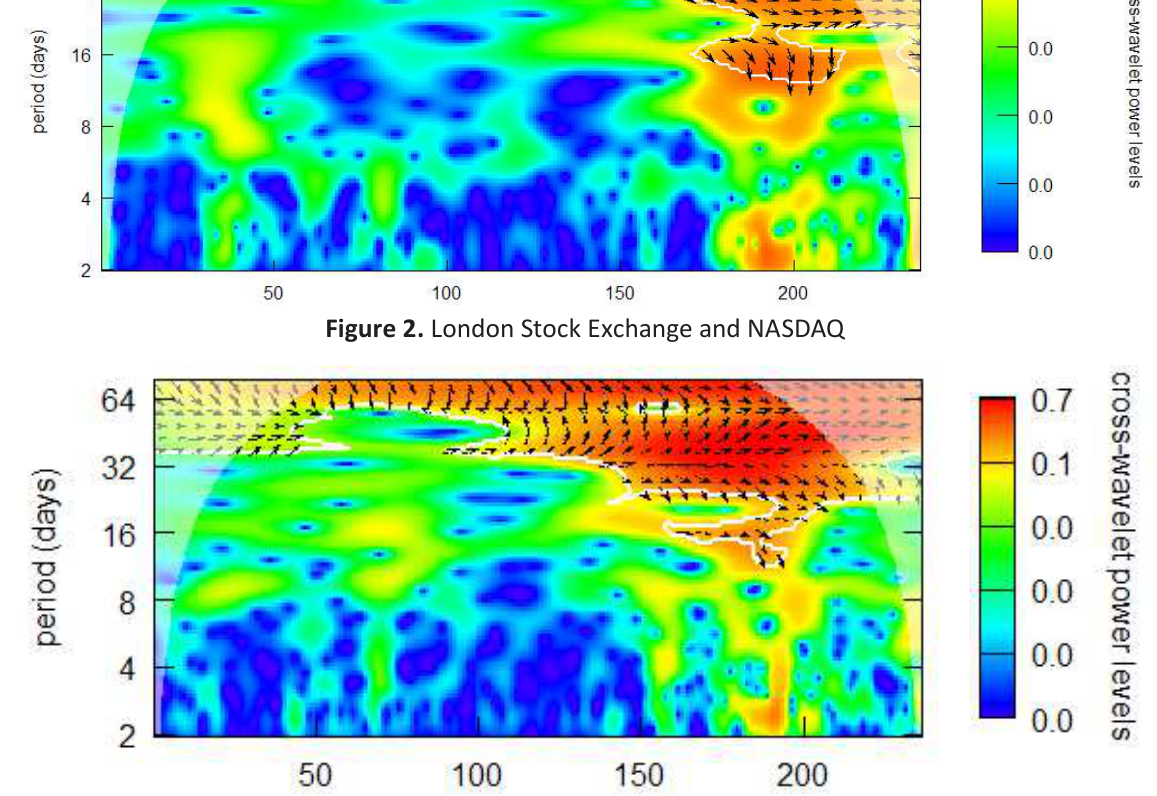
Figure 3. Shanghai Stock Exchange and